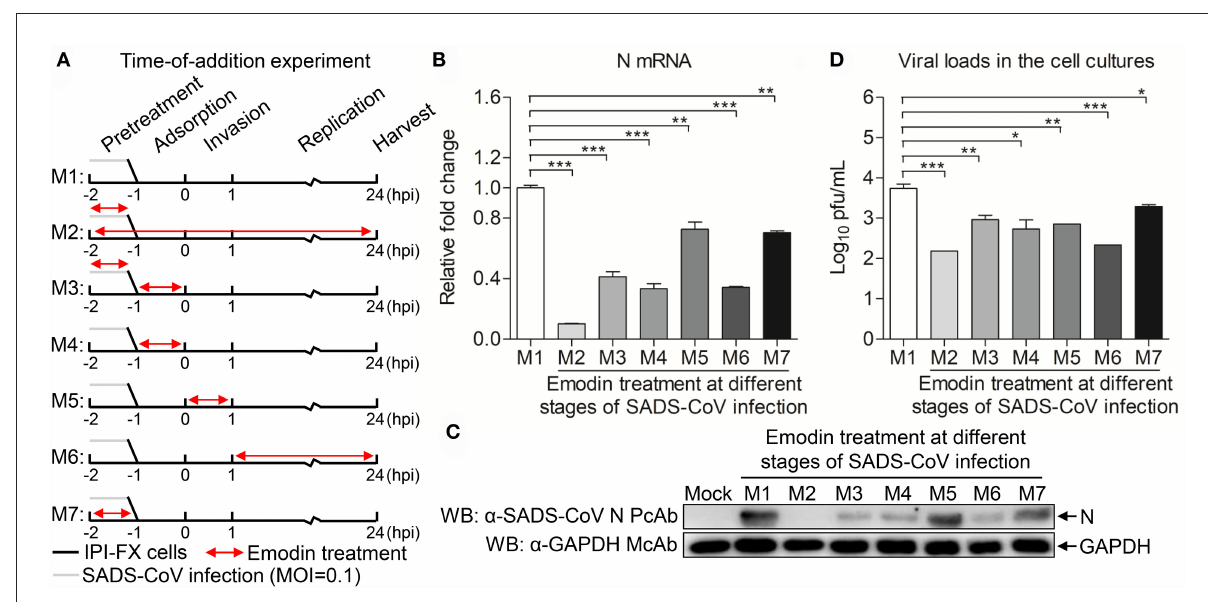
FIGURE4 Emodin inhibits SADS-CoV infection at multiple steps of the virus life cycle. (A) SADS-CoV-infected IPI-FX cells were co-incubated with Emodin (12.5 µ g/ml) or 0.1% DMSO at different stages of the viral replication cycle (M1–M7). Cell lysates were collected at 24h after infection. (B) Real-time PCR was used to examine the mRNA expression of N and GAPDH using specific primers. The expression levels of mRNA were calculated in relation to the expression level of GAPDH . (C) The expression of N and GAPDH proteins was detected by Western blot using anti-SADS-CoV N polyclonal antibody and anti-GAPDH monoclonal antibody. (D) The viral titers were measured by the TCID 50 assay. Data are representative of three independent experiments (mean ± SD). n = 3. * p < 0.05, ** p < 0.01, *** p <